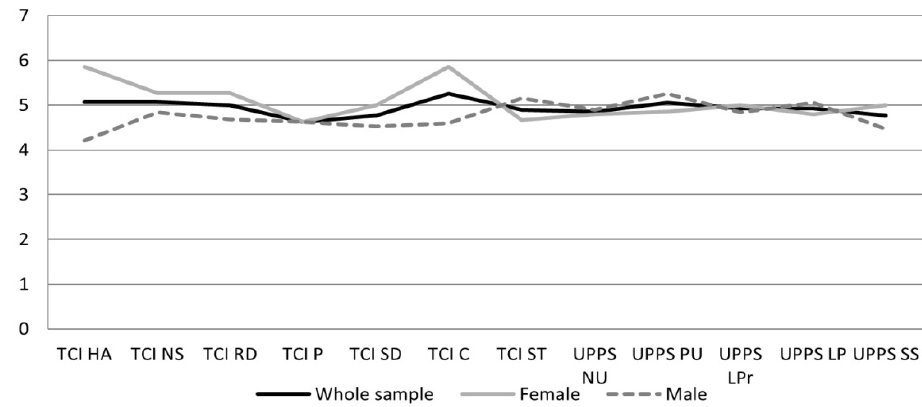
Figure 1. Short track athletes temperamental, character and impulsiveness profile, presented on the sten scale. Note: TCI-Temperament and Character Inventory; UPPS-Urgency, Premeditation (lack of), Perseverance (lack of), Sensation-Seeking, Positive Urgency, Impulsive Behavior Scale; HA-harm avoidance; NS-novelty seeking; RD-reward dependence; P-persistence; C-cooperativeness; SD-self-directedness; ST-self-transcendence; NU-negative urgency; PU-positive urgency; LPr-lack of premeditation; LP-lack of perseverance; SS-sensation seeking.